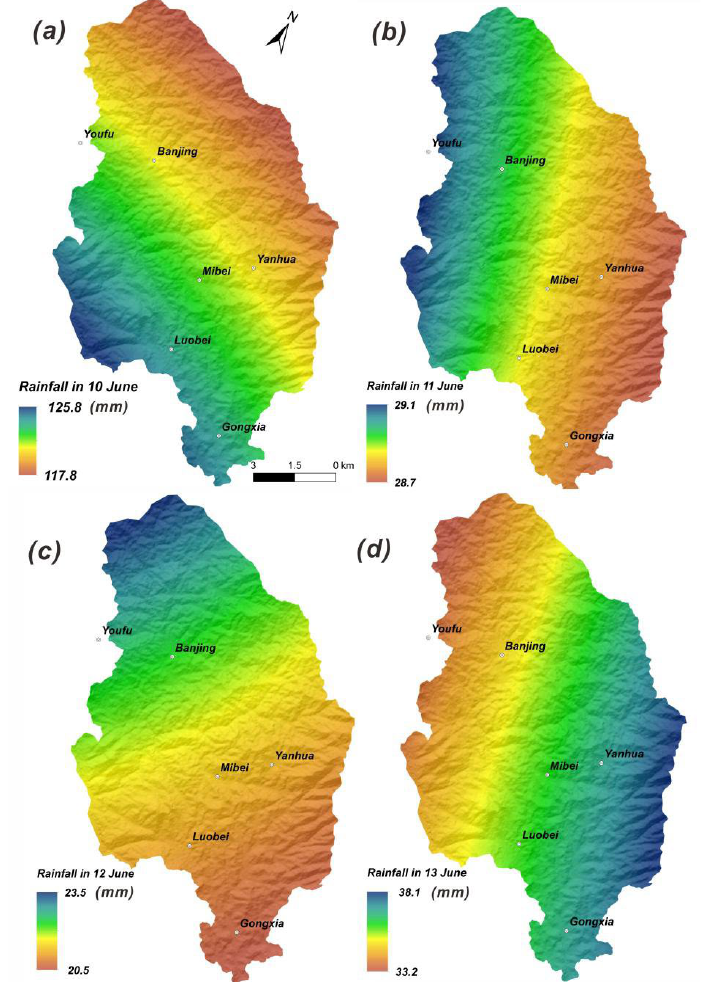
Figure 8. Mapping shows the distribution of daily rainfall from the 10th to 13th of June during this rainfall event; ( a ) 10 June 2019; ( b ) 11 June 2019; ( c ) 12 June 2019; ( d ) 13 June